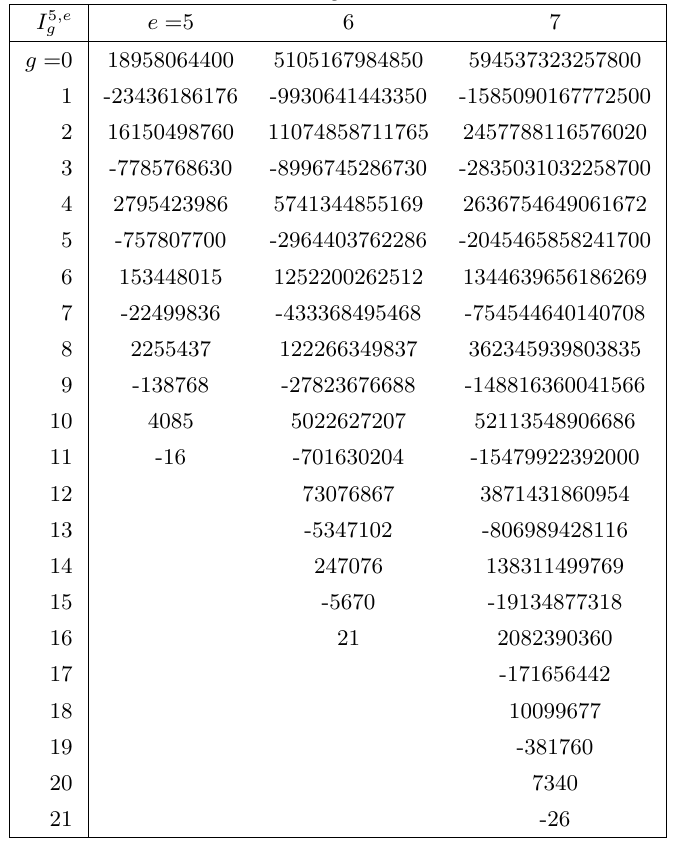
Table 12 . Unrefined BPS indices I n b ,n e